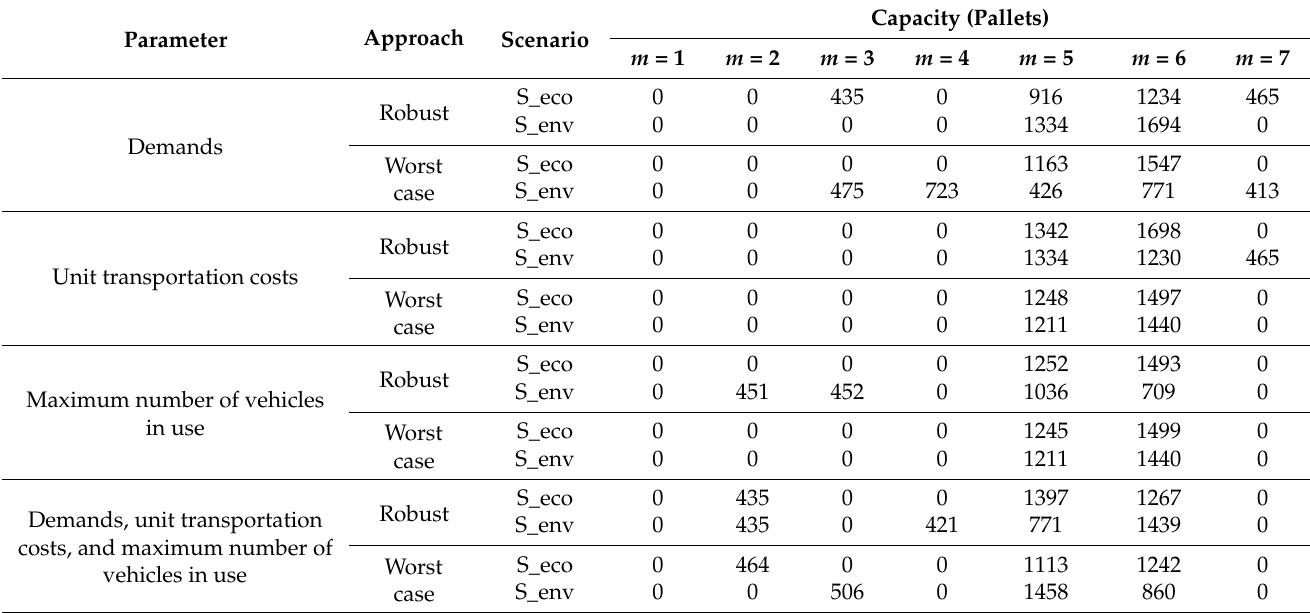
Table 8. Capacities of upstream hubs (pallets).